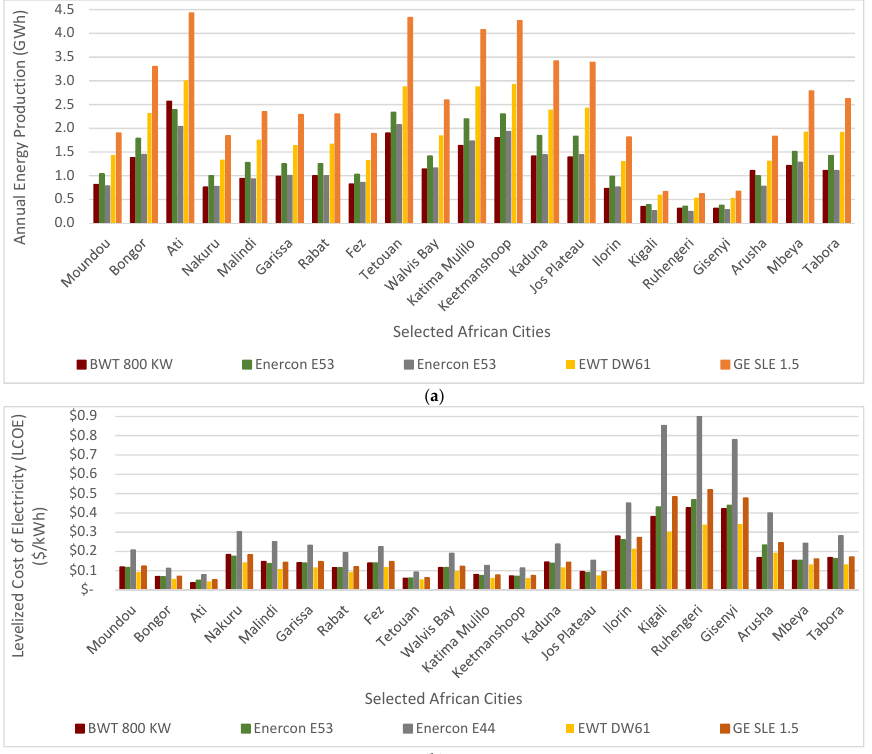
Figure 10. Comparison of ( a ) Annual Energy production and ( b ) Levelized Cost of Electricity between BWT and other existing commercial wind turbines. These results show the competitiveness of the BWT for operation in comparison with commercial wind turbines, especially for low wind condition locations, such as those in the African continent. Although the EWT DW61 has a slightly lower LCOE in the cities tested, the BWT 800 kW has a robust design and a wider range of applications to all classes of wind resources, and therefore, with commercialization, the BWT would have lower cost in the long run. The FWT technology is a strong candidate to increase the availability of economic, green, sustainable energy in Africa.